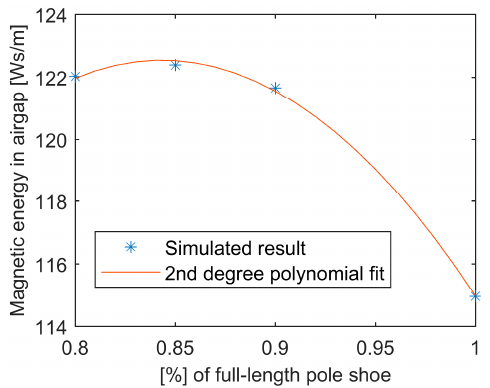
Figure 9. The magnetic energy per unit stack length in the airgap (Ws/m) for a different length of the T-shaped pole shoe.